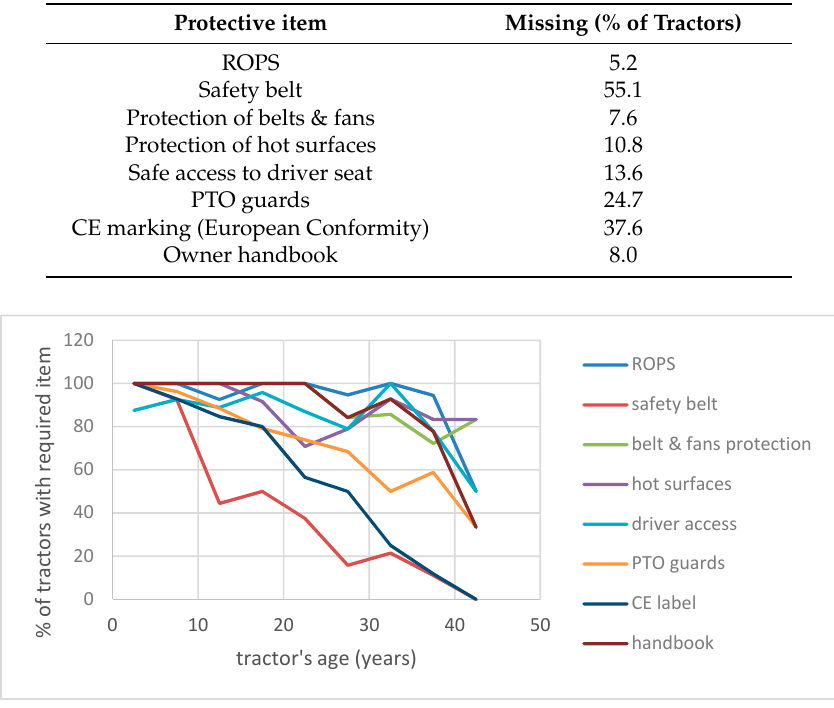
Figure 2. Tractors with required protective items in place.